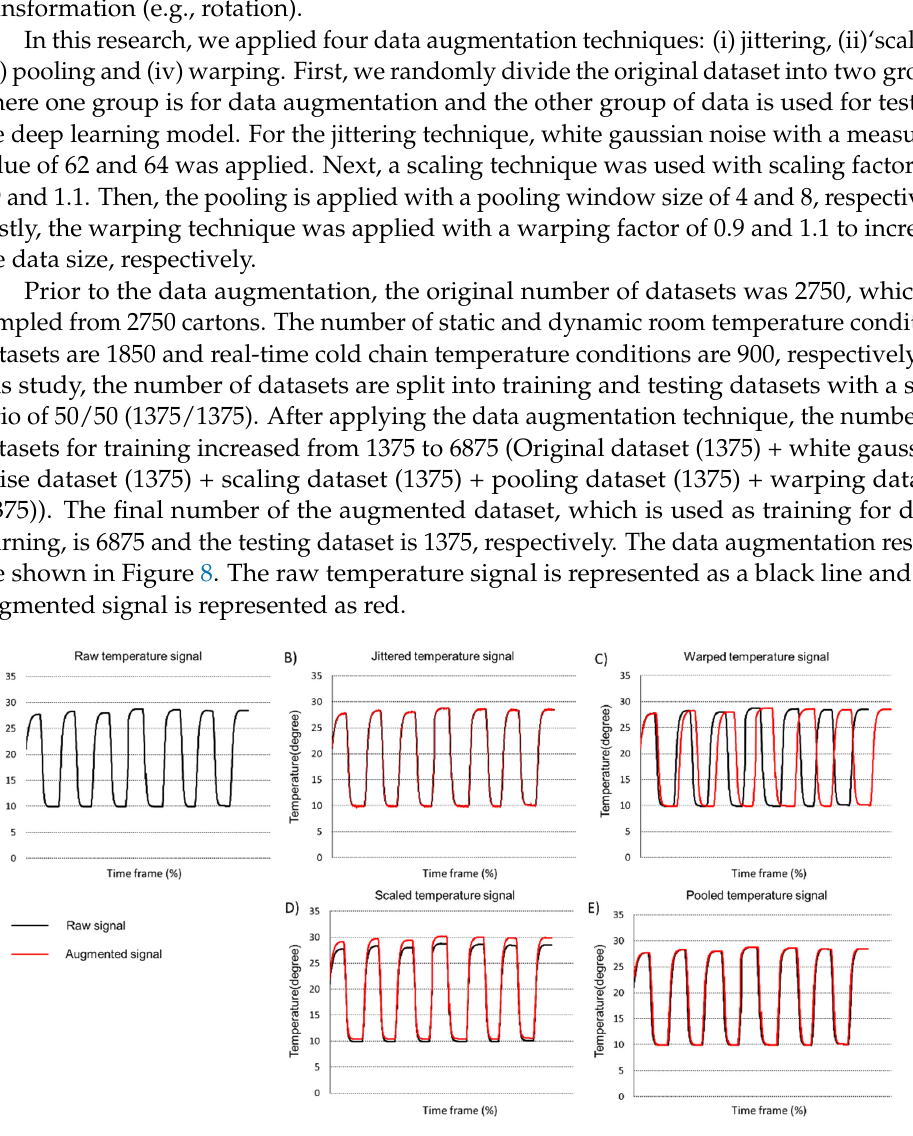
Figure 8. Implementation of four different data augmentation techniques to raw temperature signal: ( a ) raw temperature signal; ( b ) jittered data augmented signal; ( c ) time-warped data augmented signal; ( d ) amplitude scaled data augmented signal; ( e ) pooled data augmented signal.